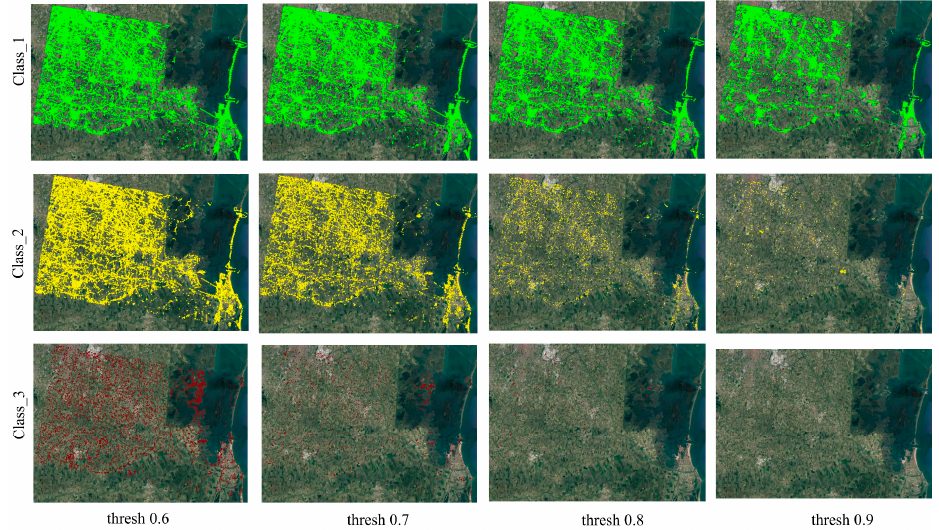
Figure 8. Spatial distribution of classified PSs per class per threshold. Maps on each row correspond to maps from each class (C 1 in green, C 2 in yellow and C 3 in maroon color) and the columns correspond